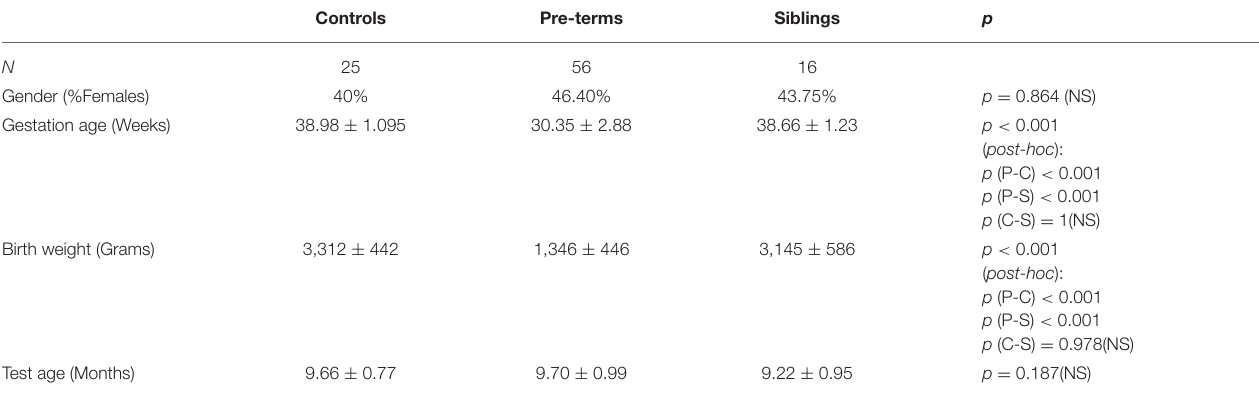
TABLE 1 | Demographic statistics as a function of risk